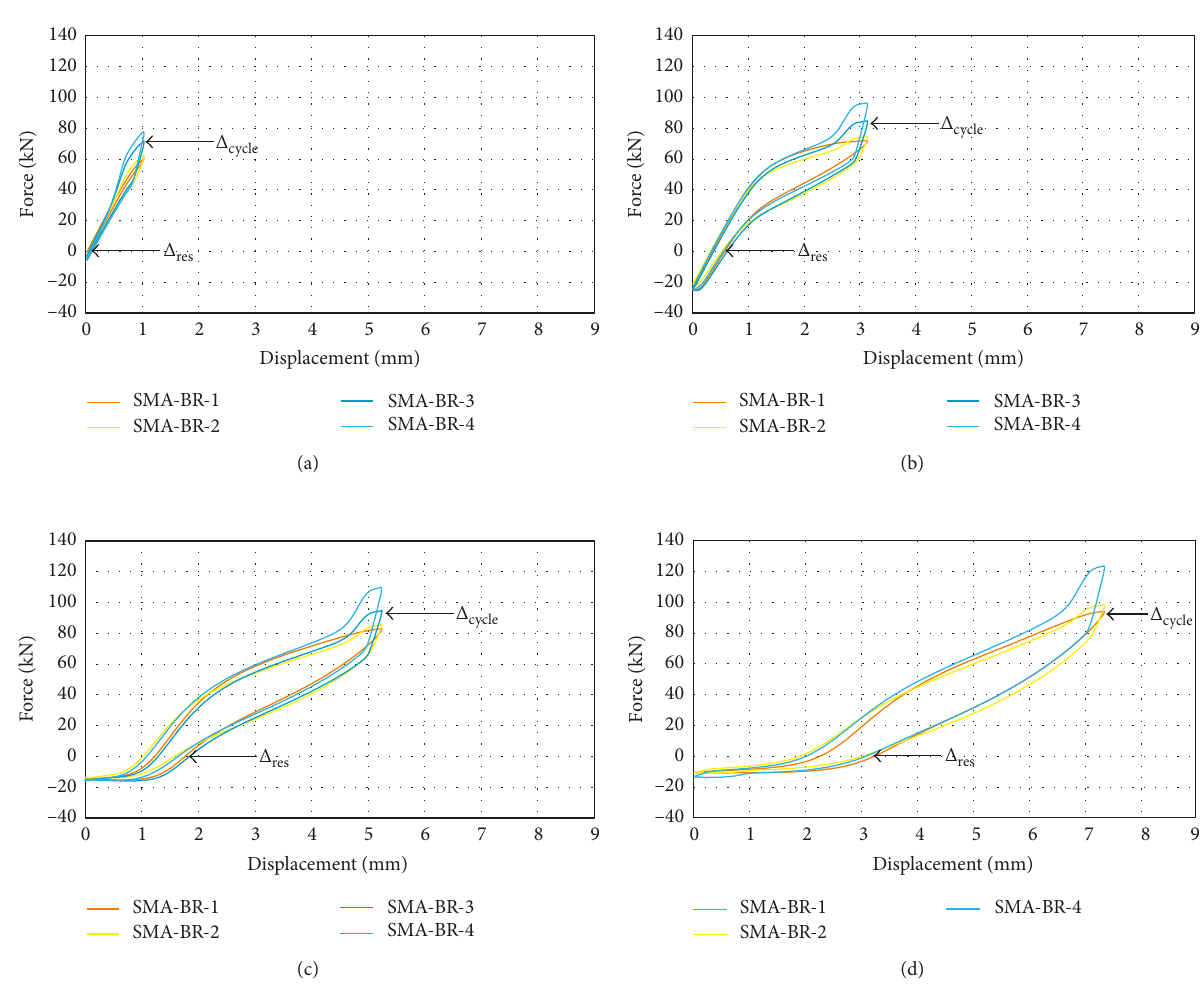
Figure 11: Force and displacement curves during loading cycles: S1 (1mm) (a), S2 (3mm) (b), S3 (5mm) (c), and S4 (7mm) (d) loading cycles.